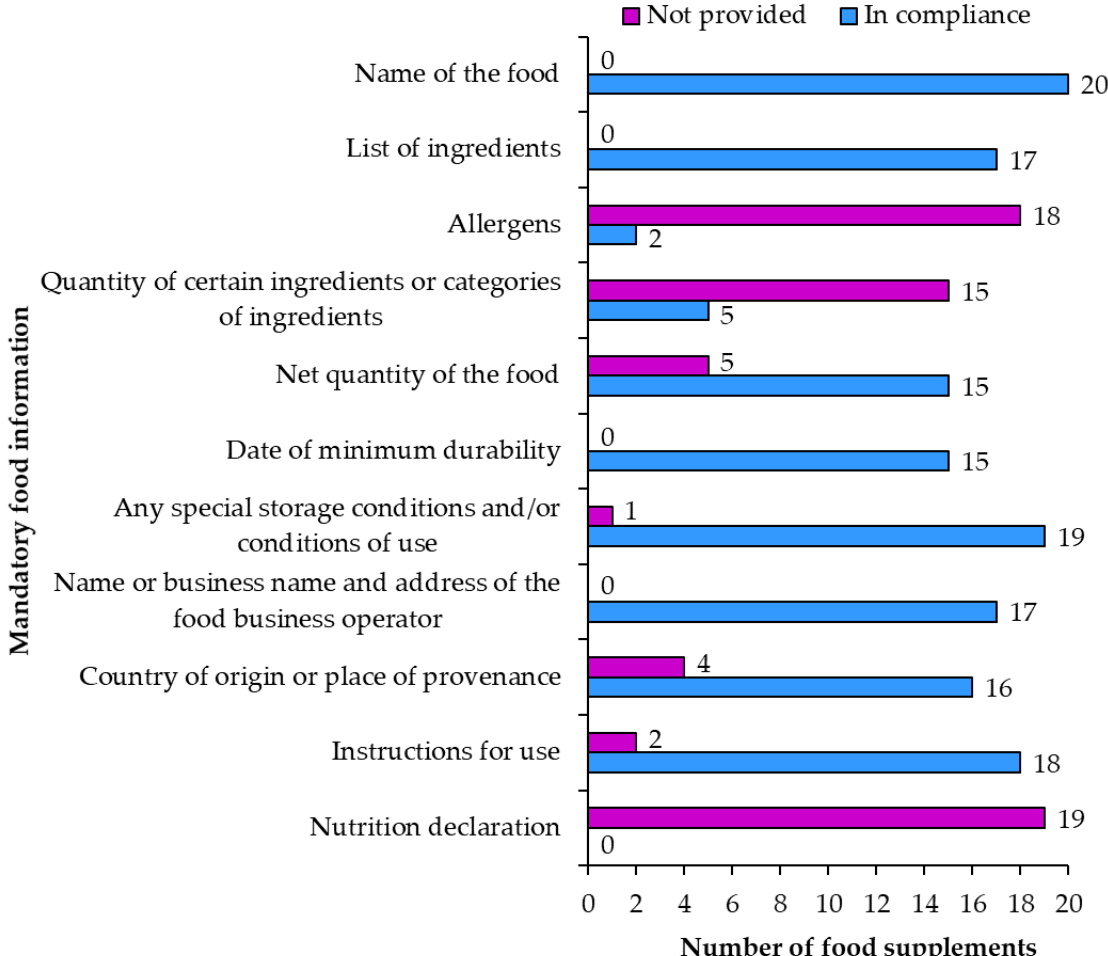
Figure 8. Compliance of mandatory food information on food supplement